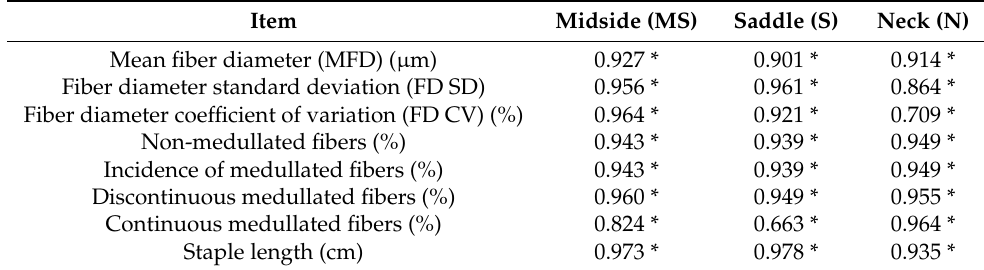
Table 5. The correlations between body sites and the fleece without pieces for wool quality character- istics in the alpacas being investigated. Item Midside (MS)